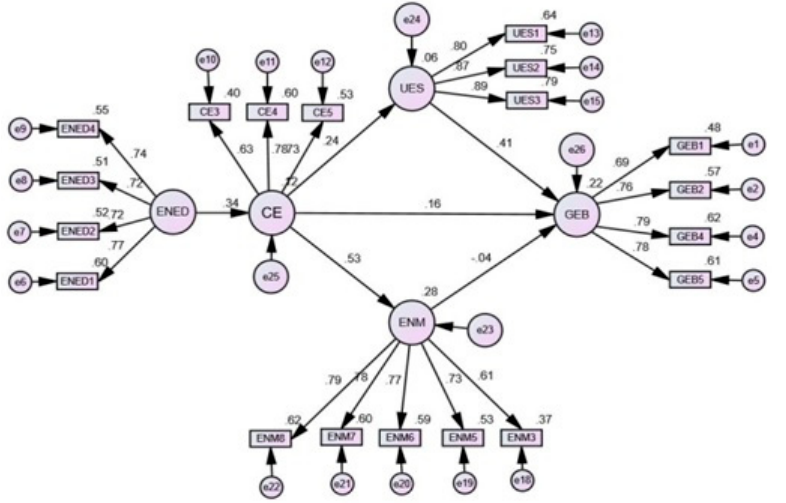
Figure 2. Structural Equation Model.